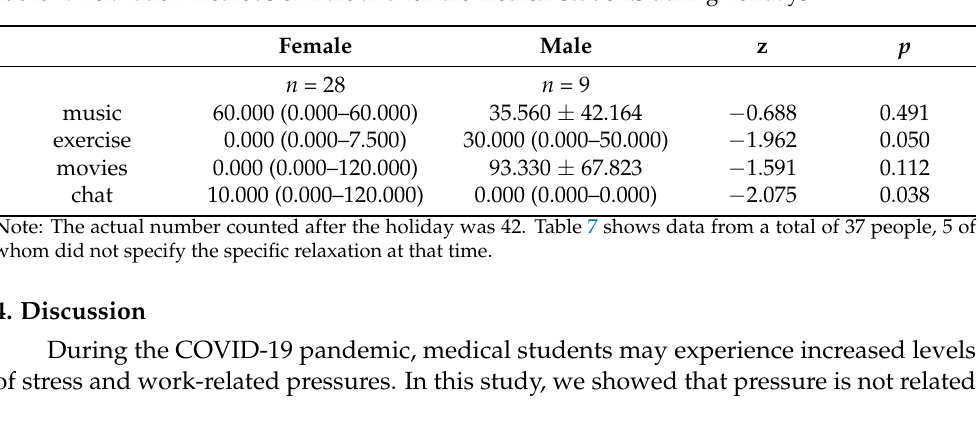
Table 7. Relaxation methods of male and female medical students during